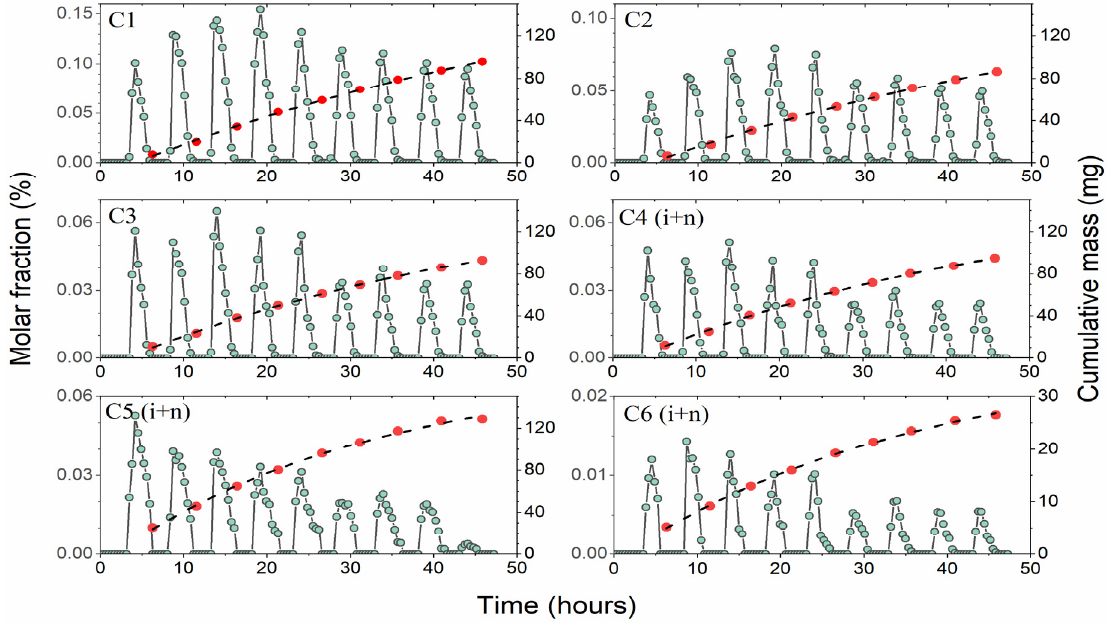
Figure 3. Molar fraction (green) and cumulative mass (red) of produced hydrocarbon gases as a function of time.